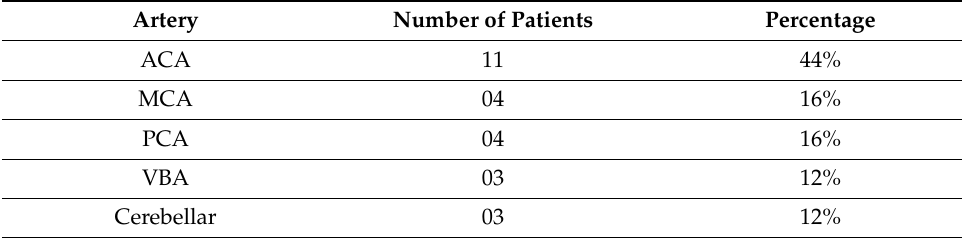
Table 3. Artery involved in participants.